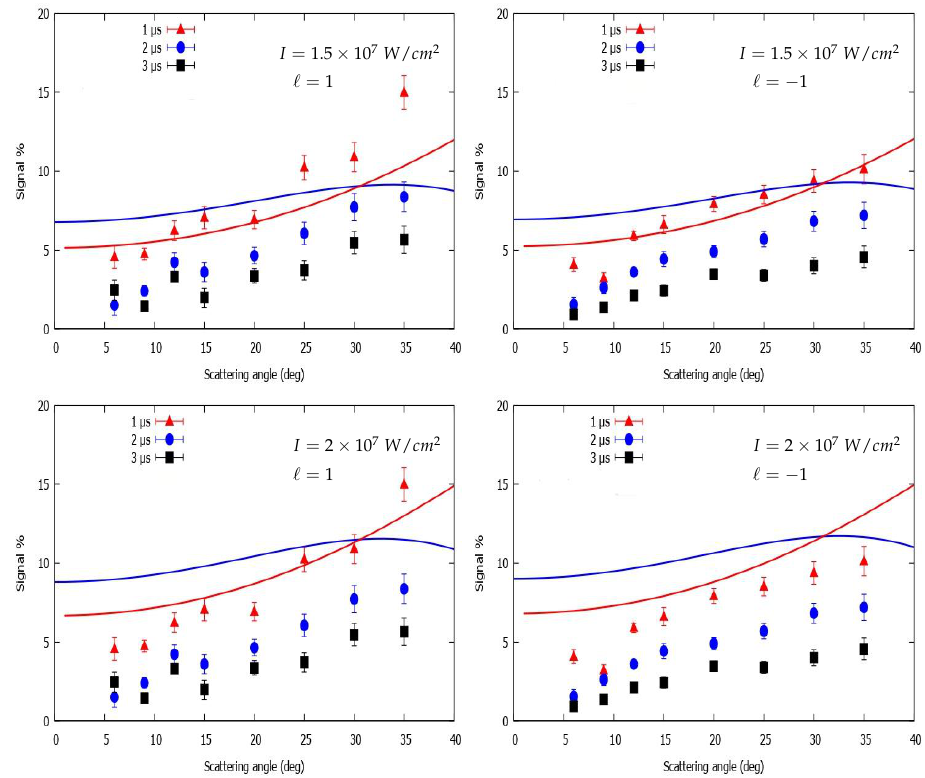
Figure 2. Same as Figure 1, but for laser intensities of 1.5 × 10 7 W/cm 2 ( upper panels) and 2 × 10 7 W/cm 2 ( lower panels).